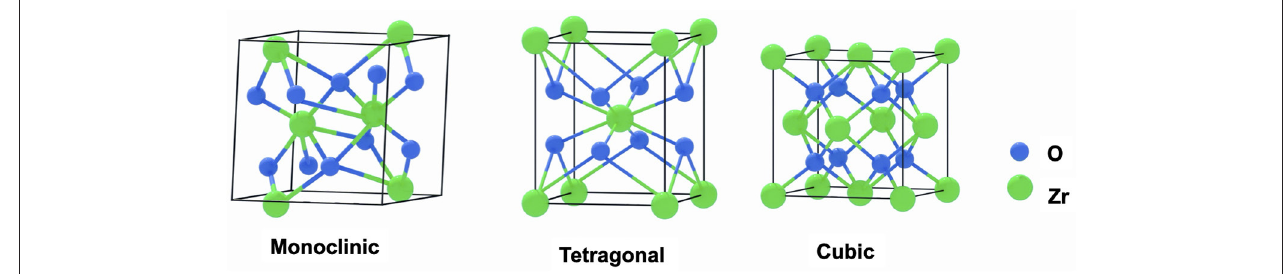
FIGURE 1 | Structure diagrams of the monoclinic phase crystal, tetragonal phase crystal, and cubic phase crystal of